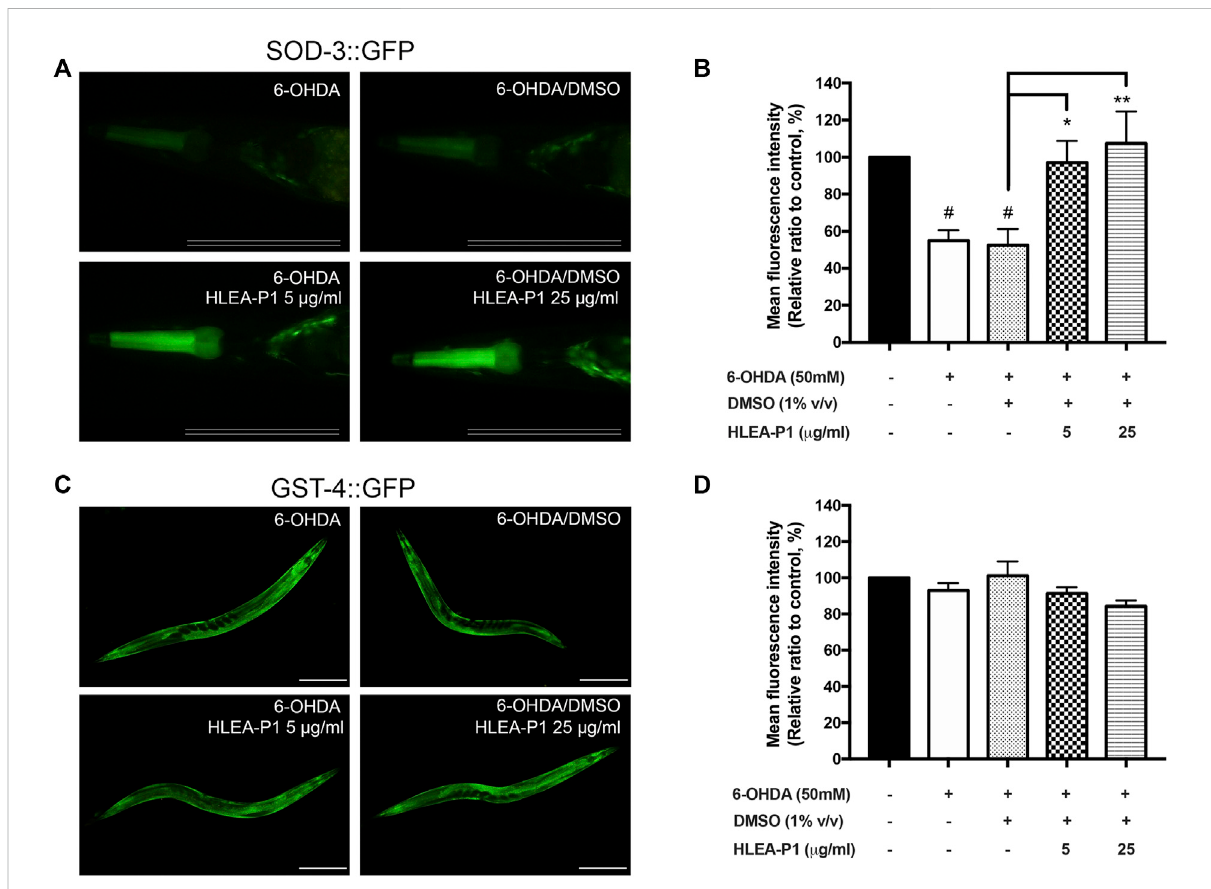
FIGURE 7 EffectofHLEA-P1 onSOD-3 andGST-4in C.elegans PDmodel. (A,B) RepresentativeSOD-3:GFPexpressionandmean fl uorescentintensity of SOD-3:GFP in transgenic CF1553 in different conditions (normal CF1553, 6-OHDA-induced CF1553, 6-OHDA/DMSO-treated CF1553, and 6- OHDA-induced CF1553 treated with HLEA-P1 at 5 and 25 μ g/ml). Scale bar is 100 μ m. (C,D) Representative GST-4:GFP expression and mean fl uorescent intensity of GST-4:GFP in transgenic CL2166 in different conditions (normal CL2166, 6-OHDA-induced CL2166, 6-OHDA/DMSO- treated CL2166 and 6-OHDA-induced CL2166 treated with HLEA-P1 at 5 and 25 μ g/ml). Scale bar is 200 μ m. The hash (#) indicates a signi fi cant differencebetweenwildtypeN2andtransgenicworms( p < .05).Theasterisk (*)indicatessigni fi cantdifferencebetweenuntreatedgroup(6-OHDA/ DMSO) and HLEA-P1 treated groups, *** p <